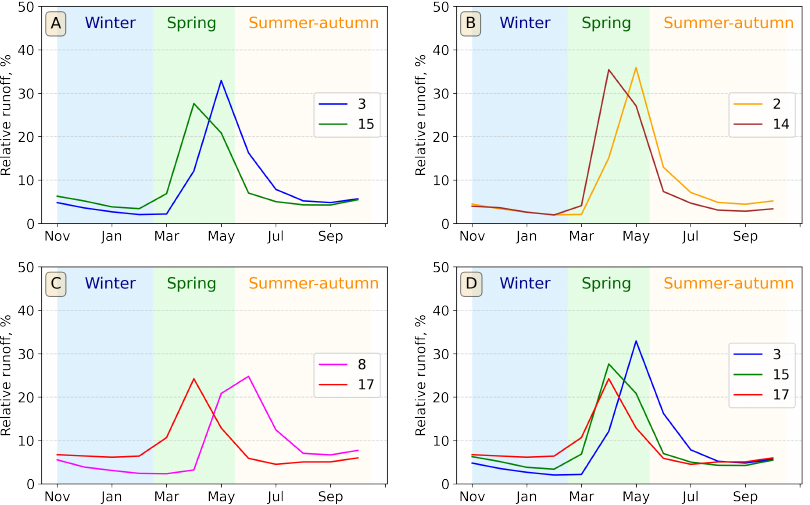
Figure 5. Pairwise comparison of monthly climatological hydrographs for different types